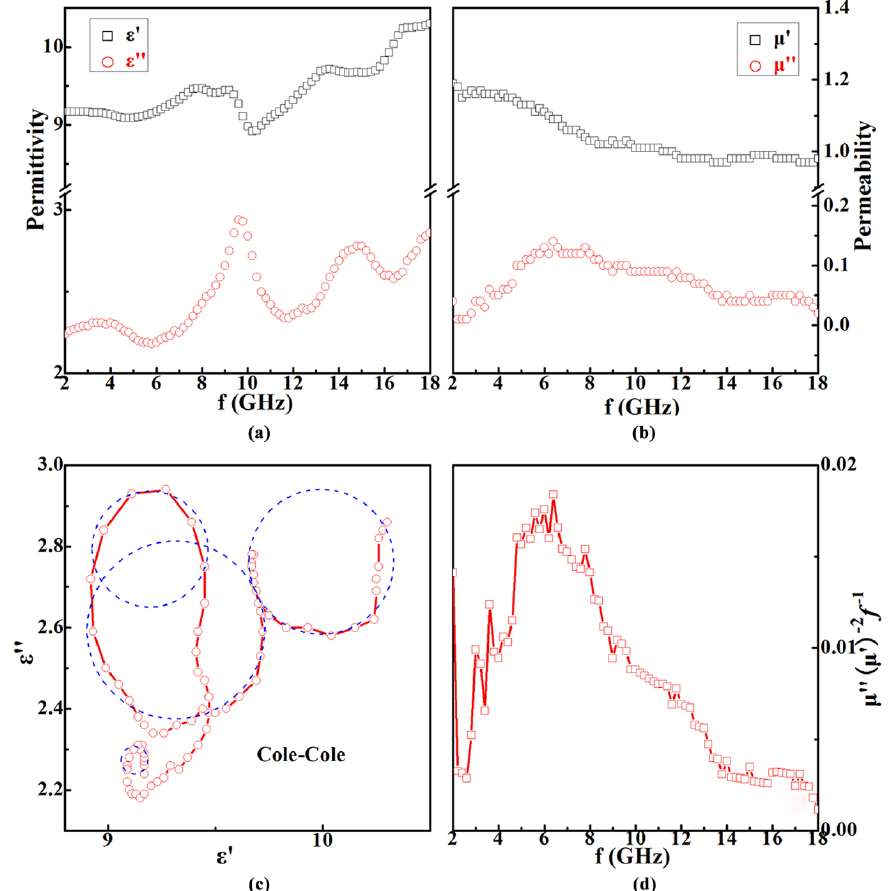
Figure 4. Frequency dependence of (a) the relative complex permittivity and (b) the relative complex permeability, (c) Cole-Cole plot. The four dashed circles are guides to the eyes, and (d) frequency dependence of μ′′(μ′) -2 f -1